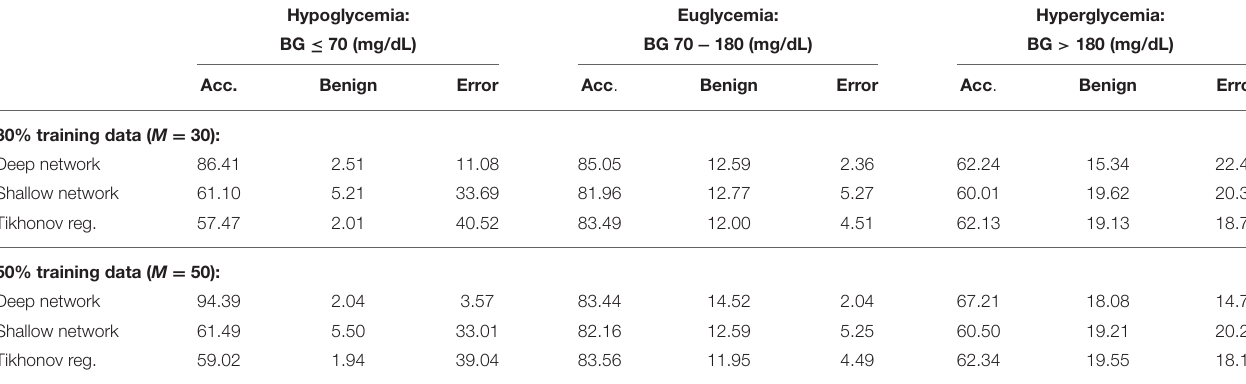
TABLE 2 | Average PRED-EGA scores (in percent): M % of patients used for training with flat low-pass filtering. Hypoglycemia: Euglycemia: Hyperglycemia: